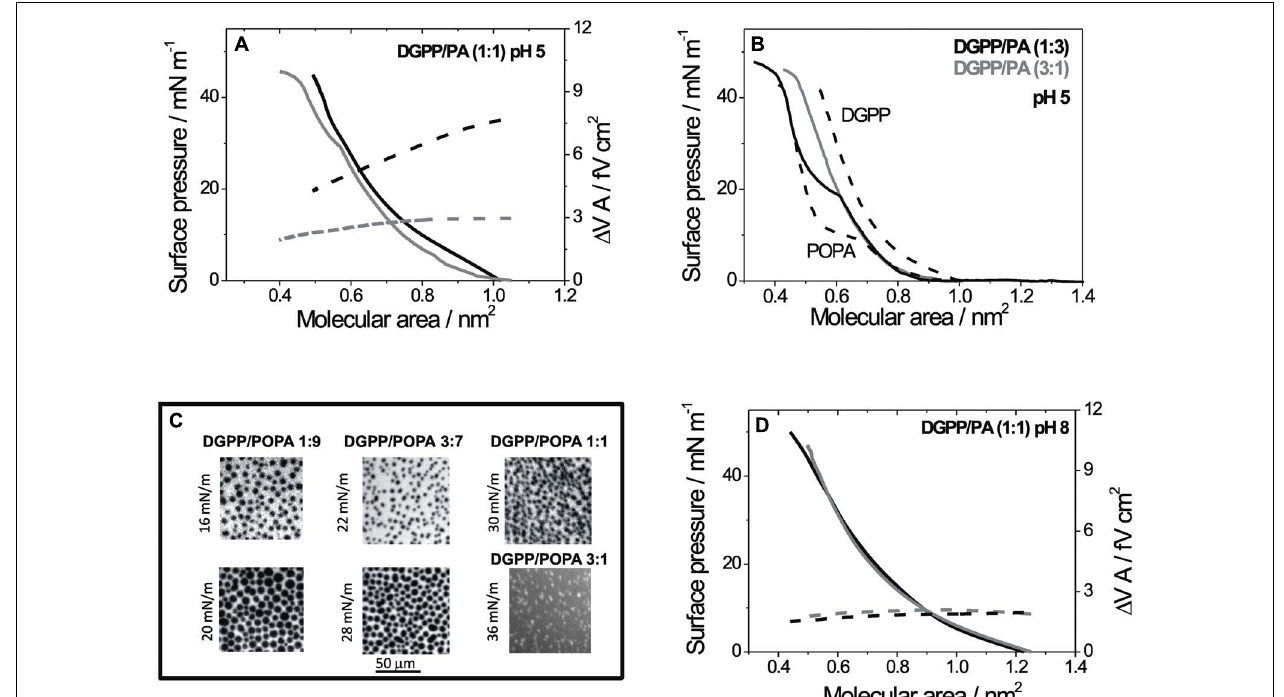
FIGURE 3 | Compression isotherms for mixed monolayers of DGPP and POPA on subphases at different pHs: (A) Lateral pressure (solid lines, left scale) and (cid:4) V · A (dashed line, right scale) as a function of the mean molecular area for monolayers composed of DGPP/POPA (1:1) on subphases at pH 5. (B) Lateral pressure as a function of the mean molecular area for monolayers composed pure DGPP and POPA (dashed lines) or mixtures of DGPP/POPA in a proportion (1:3) (black line) and (3:1) (gray line). (C) Representative images